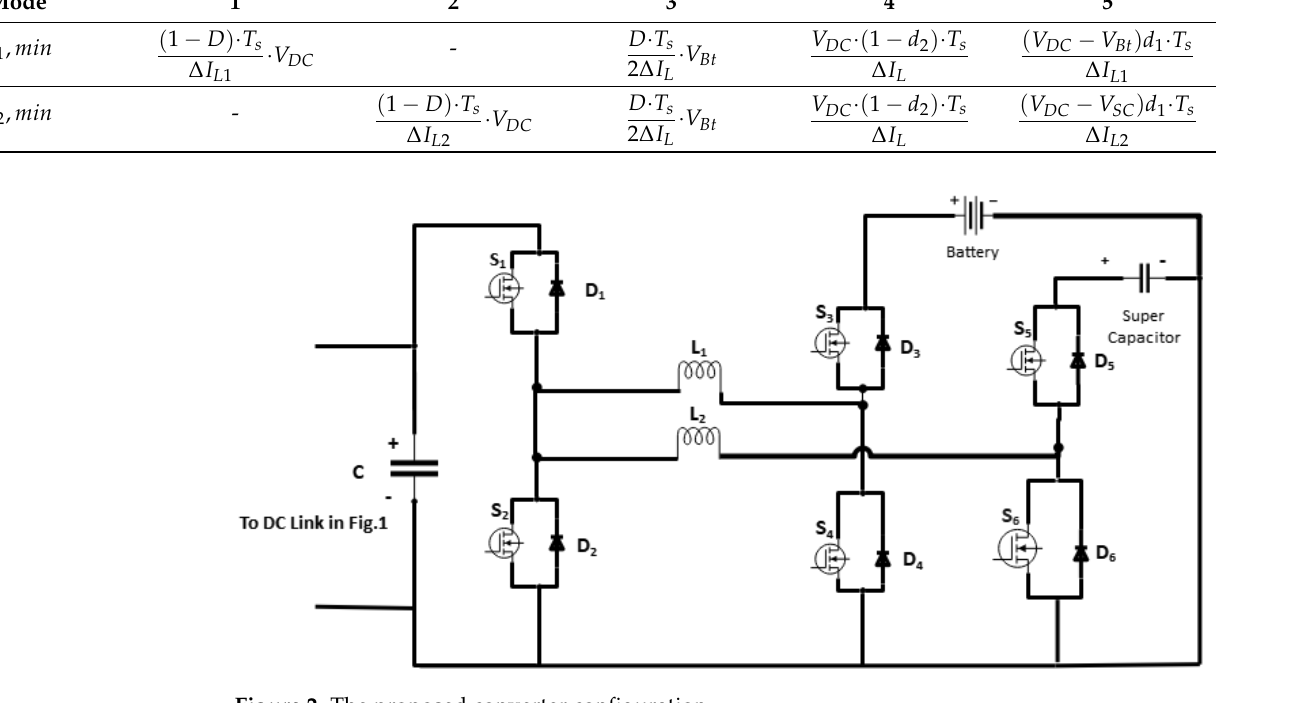
Figure 2. The proposed converter configuration. Table 3. Design specifications of the proposed converter.